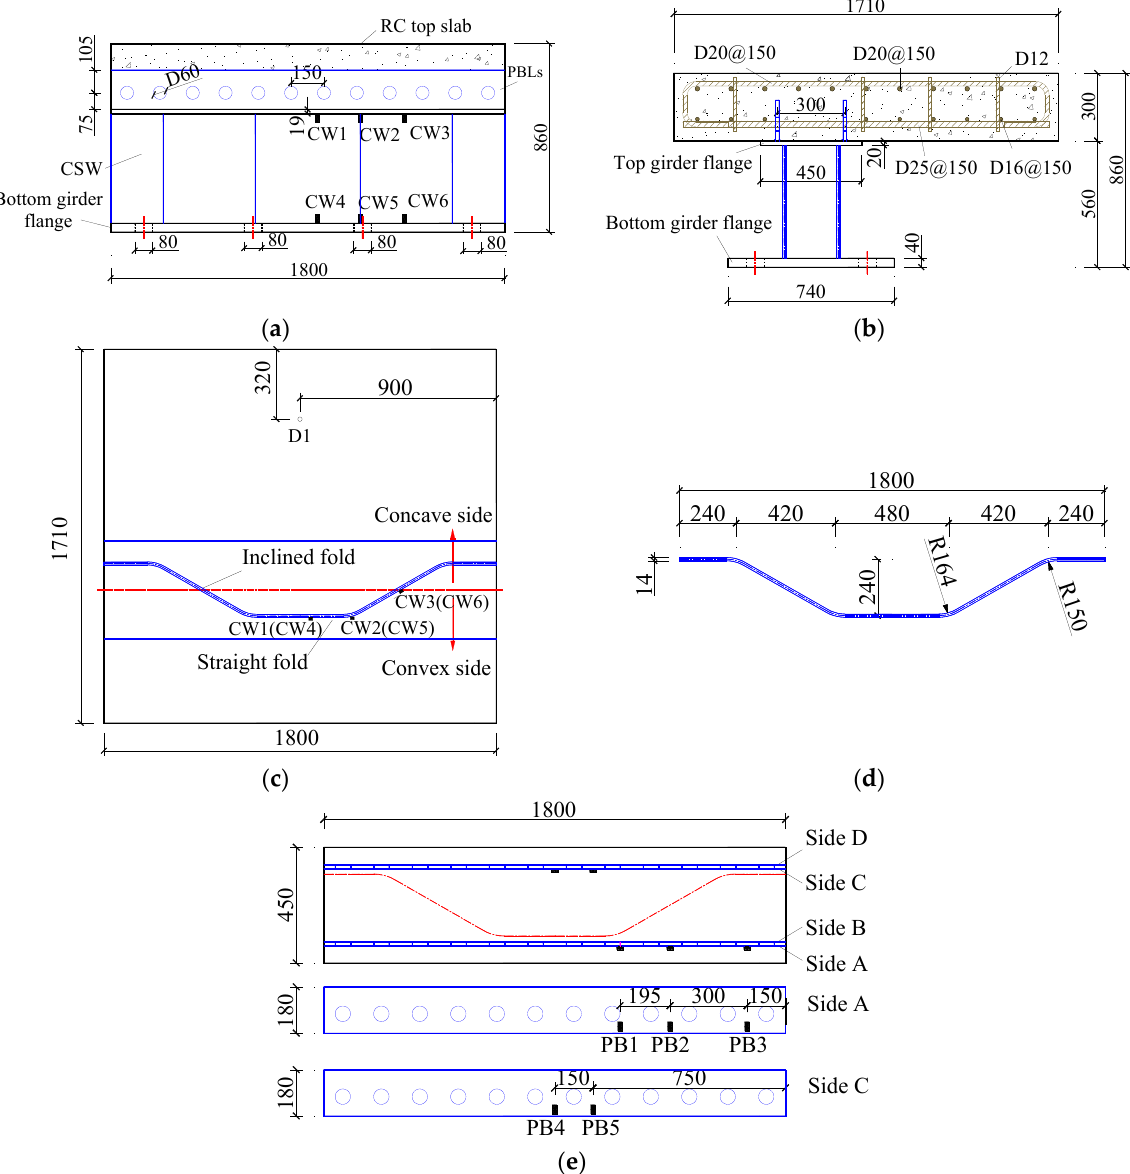
Figure 2. Design details and layout of the measuring points: ( a ) front view; ( b ) side view; ( c ) top view; ( d ) dimensions of the CSW; ( e ) measuring points on the PBL